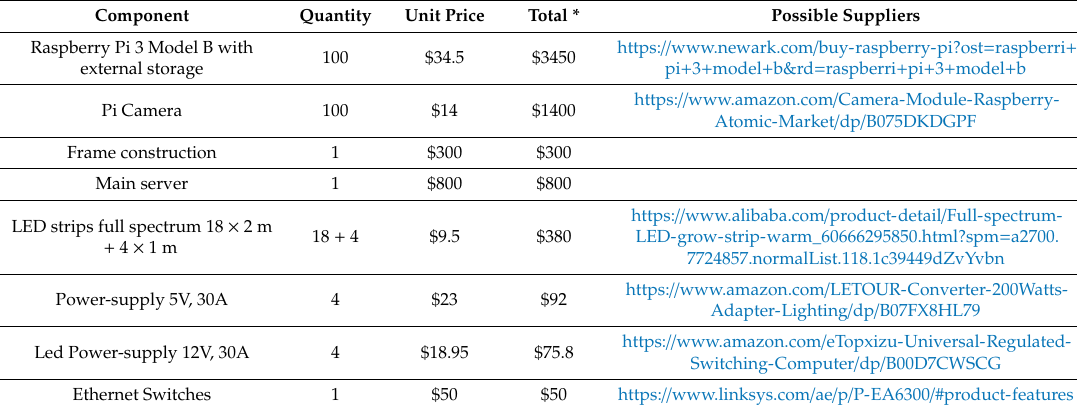
Table 2. Hardware costs of the developed human body 3D